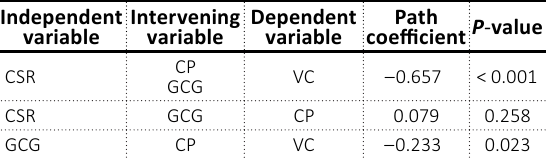
Table 8. Indirect effect and p -values